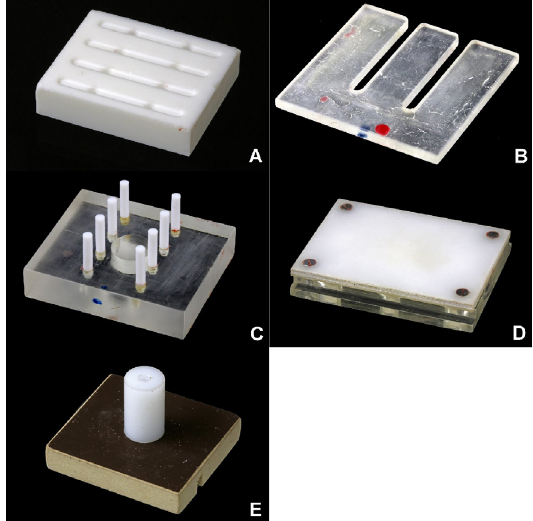
Figure 1. Teflon matrix for obtaining the acrylic resin standards: A - Upper part; B - 0.7 mm spacer; C - Spacer positioning device; D - Acrylic resin pressing base; E - Lower